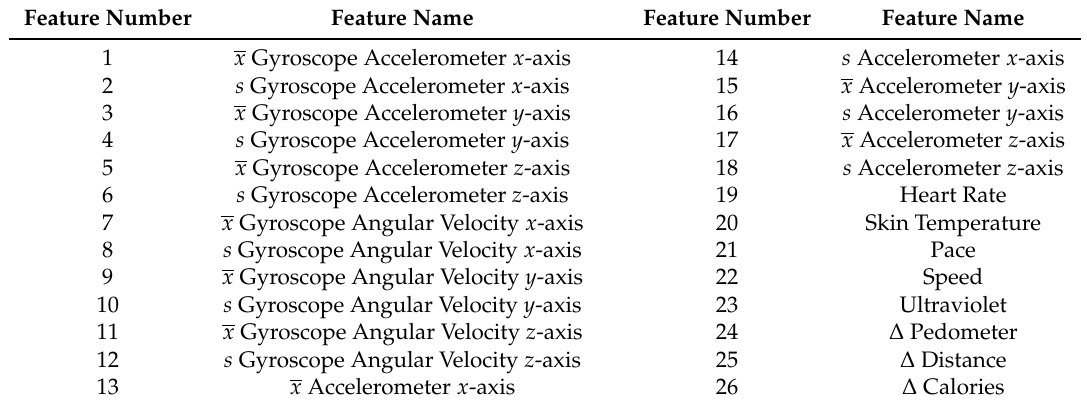
Table 2. Feature vector structure.